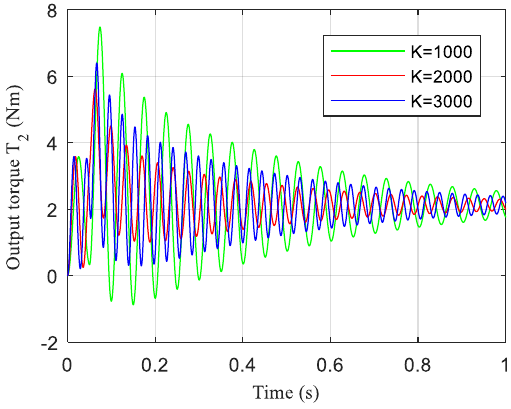
Figure 16. The response curve of the joint output torque.